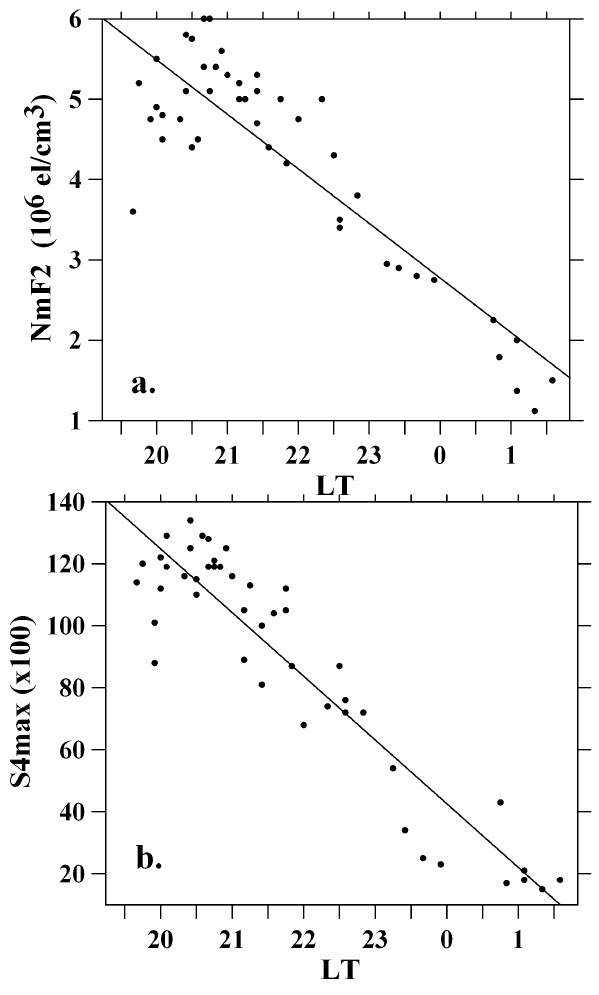
Fig. 5. Nm F2 and S4max data as functions of